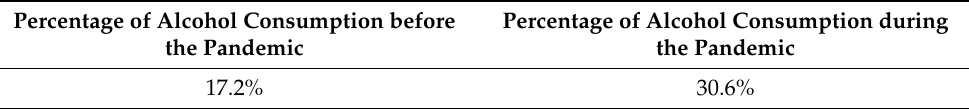
Table 7. Comparison of alcohol consumption 2–3 times per week before and during the pandemic